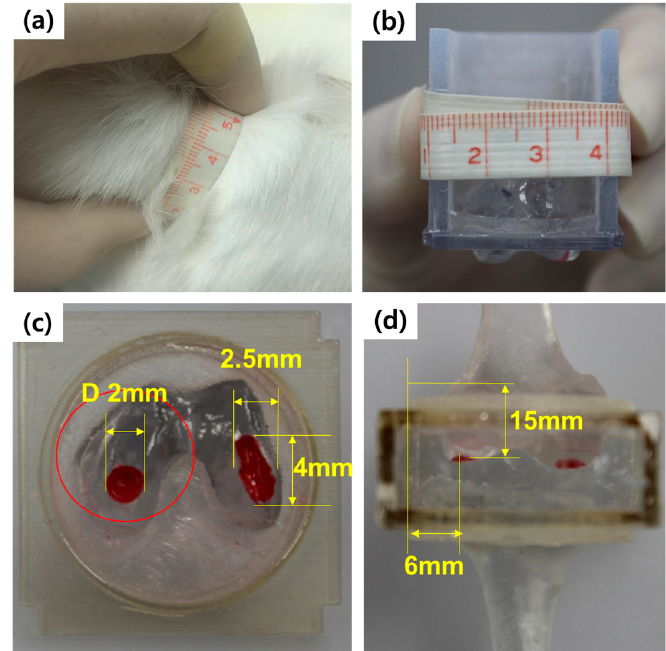
Figure 4. Dimensions of target animal and phantom model mimicking real environment. ( a ) Animal model, ( b ) phantom model, ( c ) top view of cartilage defect, and ( d ) side view of cartilage defect.